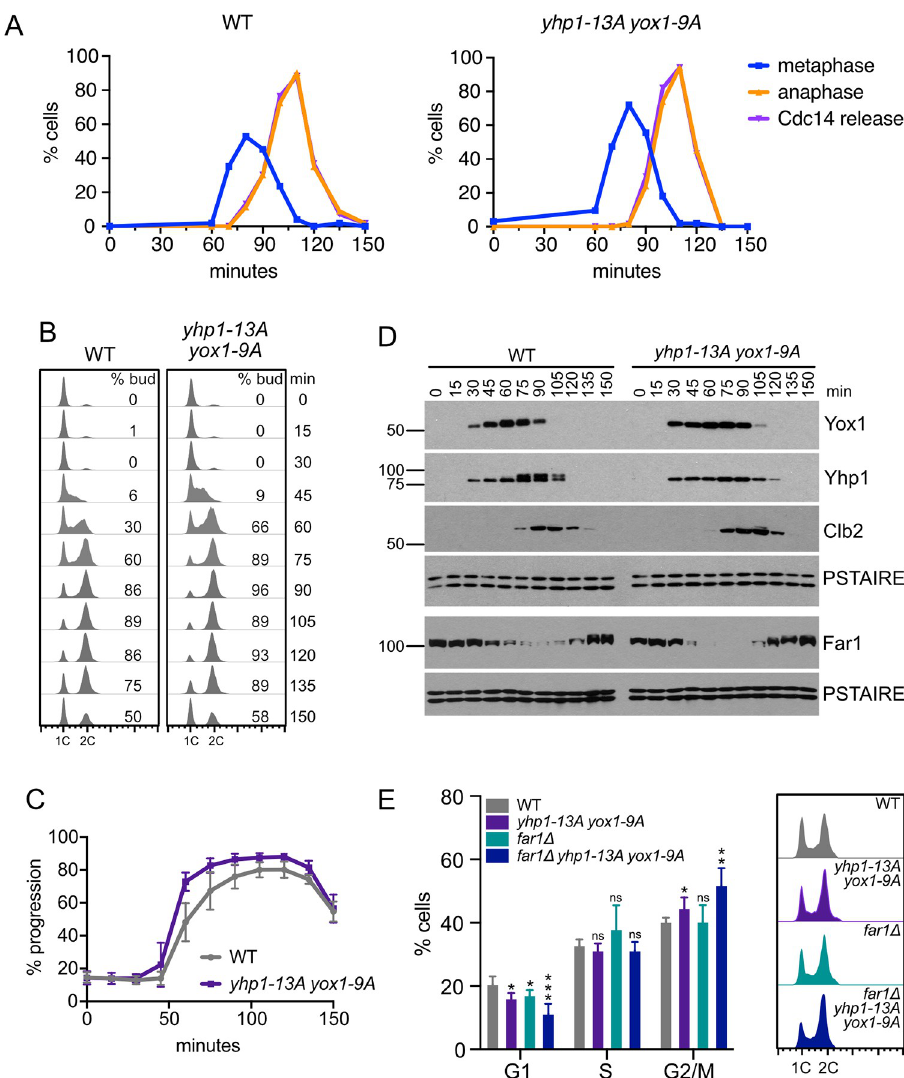
Fig 5. Altered cell cycle timing in yhp1-13A yox1-9A cells. (A) Cells were arrested in G1 with alpha factor and mitotic progression was quantified in the indicated strains following release from arrest at 23˚C. Percentage of metaphase and anaphase spindles are shown, as well as the percentage of cells in which Cdc14 has been released from the nucleolus. A representative experiment is shown. See S6 Fig for mean percentage of metaphase spindles at the 60-minute time point from n = 3 experiments. (B) DNA content of the indicated strains following release from a G1 arrest at 23˚C, as in (A). Percentage of budded cells at each time point is indicated. Shown is a representative experiment. (C) Quantitation of DNA content as a proxy for cell cycle progression. Shown are average values from n = 3 experiments performed as described in (A), error bars indicate standard deviations. (D) Western blots of 3V5-tagged Yox1/Yox1-9A, 13Myc-tagged Yhp1/Yhp1-13A, Clb2 and 3V5-tagged Far1 following release from G1 arrest at 23˚C. PSTAIRE blots are shown as loading controls. (E) DNA content was measured by flow cytometry in the indicated strains growing asynchronously at 23˚C. Average percentage of cells in each phase is shown in the graph at the left, representative plots are shown at the right. Graph shows an average of n = 6 replicates, errors bars indicate standard deviations. Significance of the changes in each genotype compared to WT were determined by repeated measures two-way ANOVA with Geisser-Greenhouse correction and Holm-Sˇı´da´k’s multiple comparisons test, � p < 0.05, �� p < 0.01, ��� p < 0.005, ns =